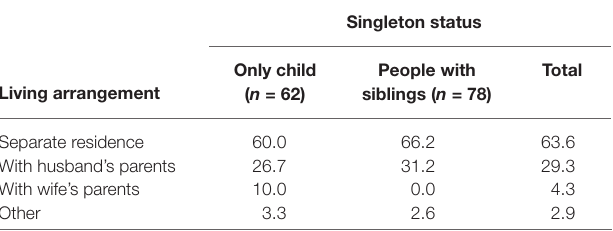
TABLE 4 | Living arrangement after marriage by singleton status (%).